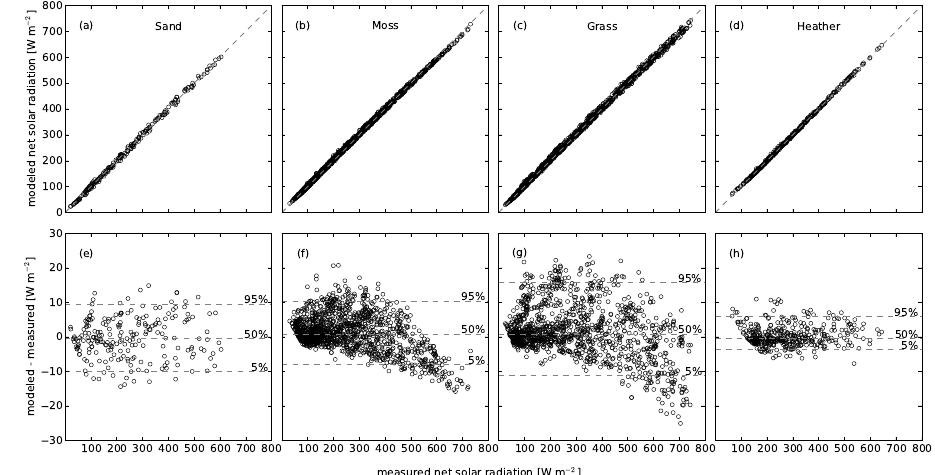
Figure 7. Modeled compared to measured net solar radiation (panels a–d , dashed lines are 1 : 1 lines) and deviations from the 1 : 1 line (panels e–h ; dashed lines indicate 5, 50 and 95 percentiles).